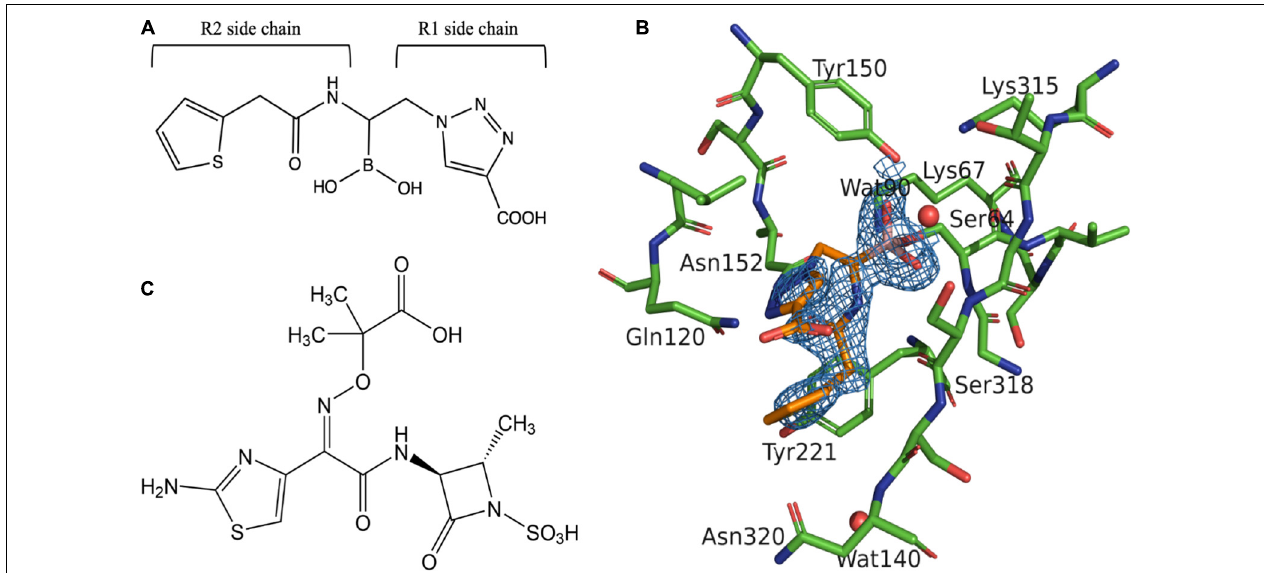
FIGURE 1 | Structure of aztreonam (ATM) and S02030 bound to MOX-1 β -lactamase. (A) Chemical structure of S02030. (B) Electron density of S02030 bound to the active site of MOX-1. (C) Chemical structure of ATM.